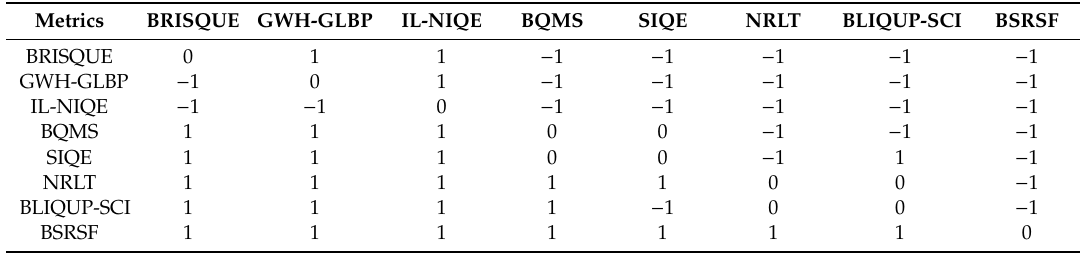
Table 4. Experimental results of F-tests on SIQAD.